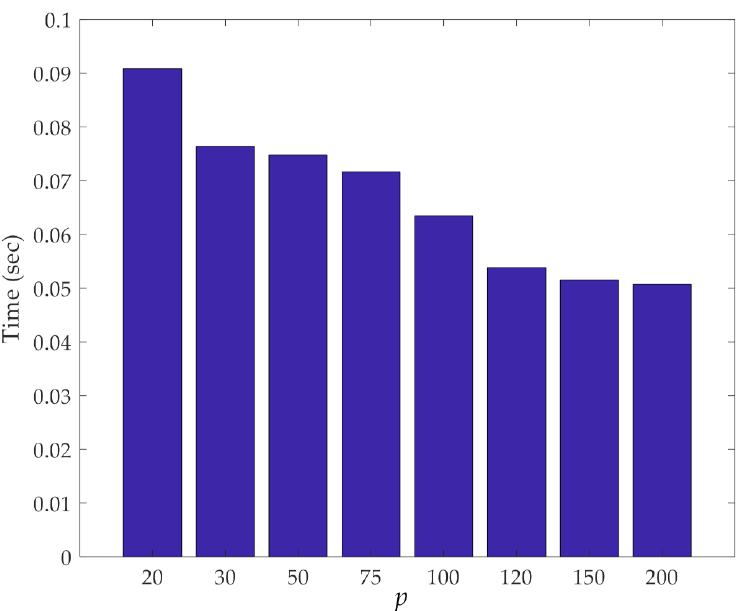
Figure 13. Z24 Bridge: effect of the number p of partitions on the computing time relevant to the iterative